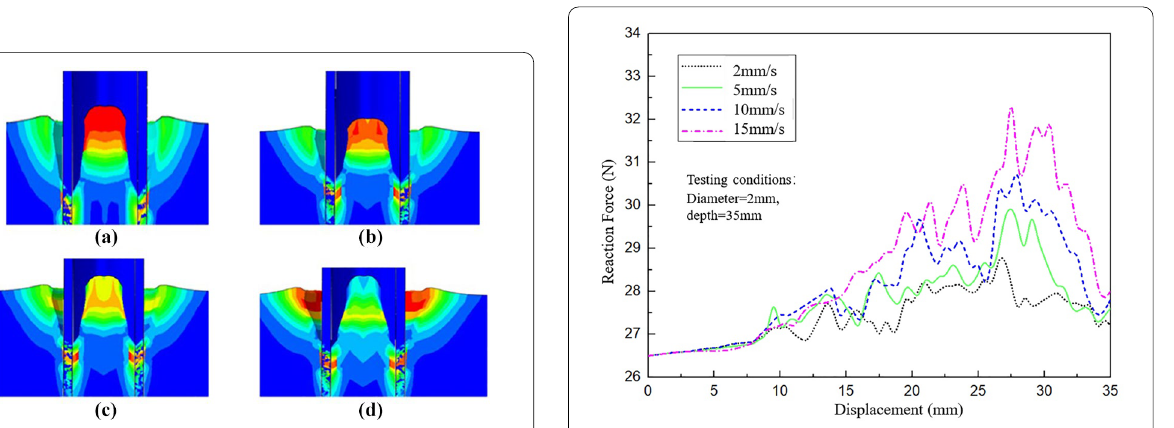
Figure 16 The reaction force of puncture needle in the process of puncture under different puncture